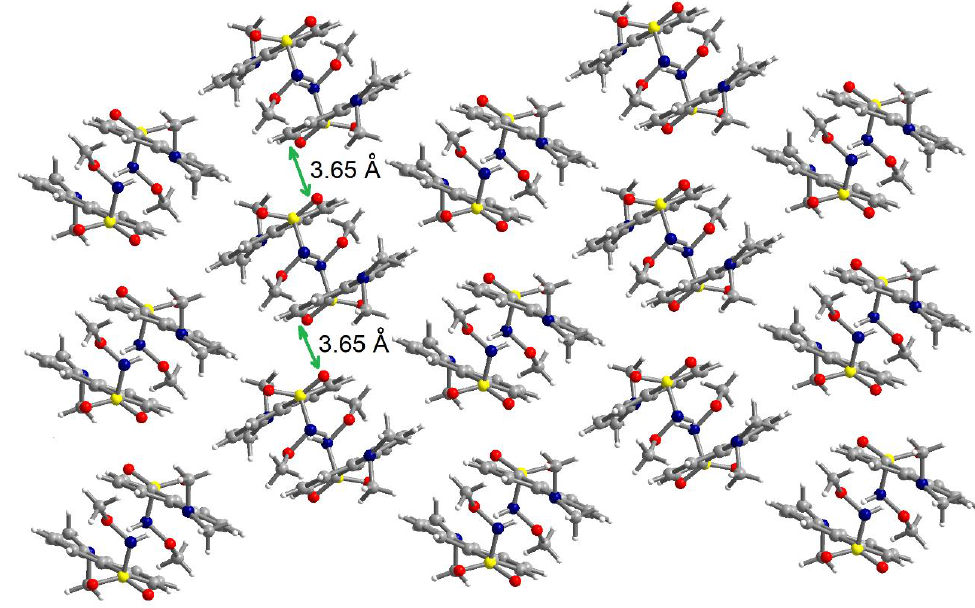
Figure 6. View of a packing diagram in crystal 2.